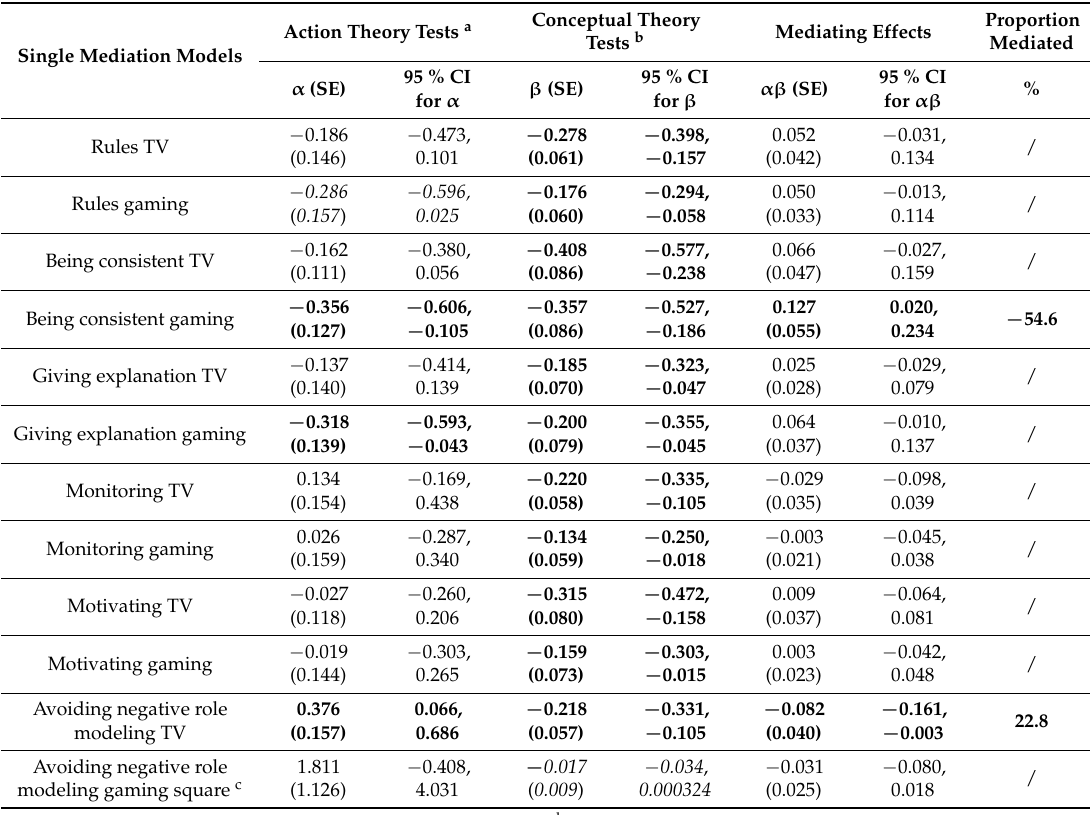
Table 3. Mediating role of parenting practices on the association between family SES and children’s screen-time.